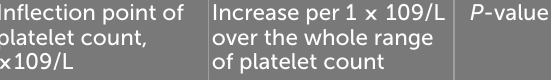
TABLE 3 Threshold effect analysis of the platelet count on intra-abdominal infection and surgical intervention. Inflection point of platelet